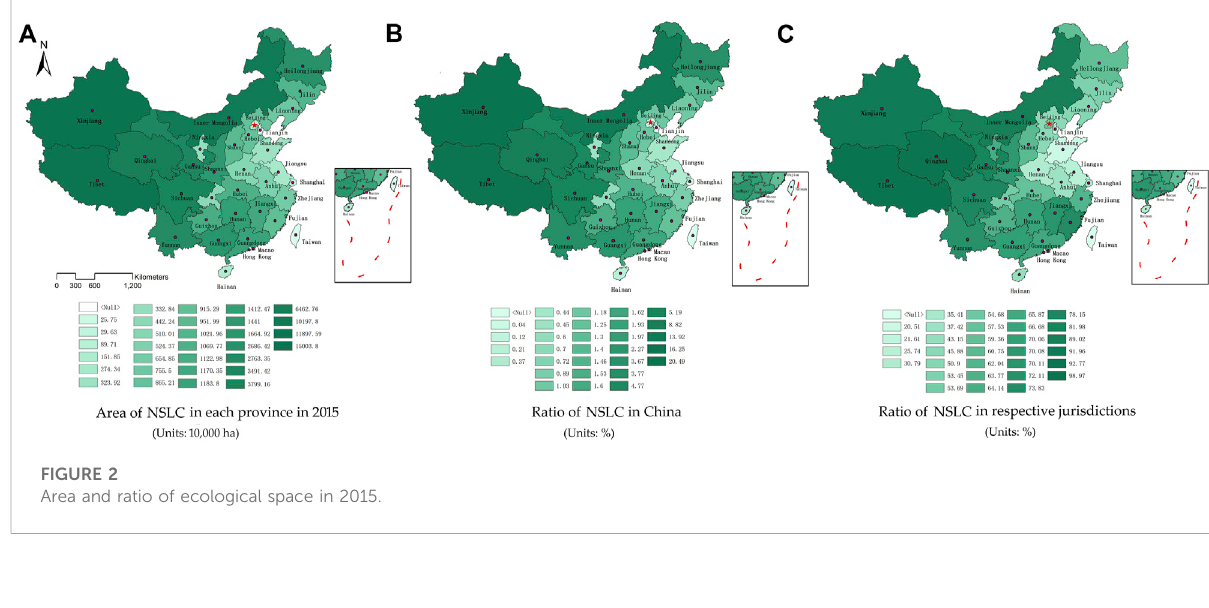
FIGURE 2 Area and ratio of ecological space in 2015.